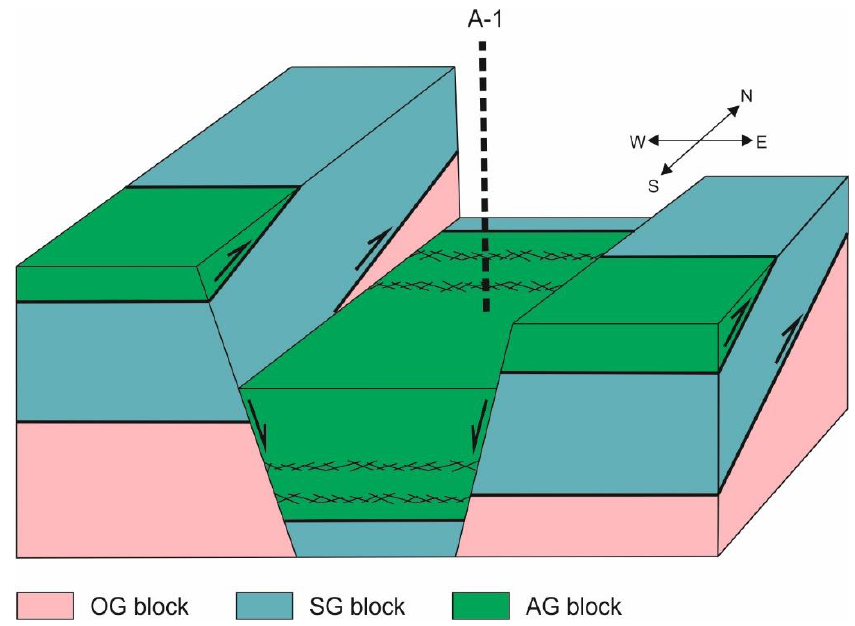
Figure 14. Block model representing the structural position of the A-1 well and its surroundings. The two highly fractured zones inside the AG block with good reservoir properties are denoted.